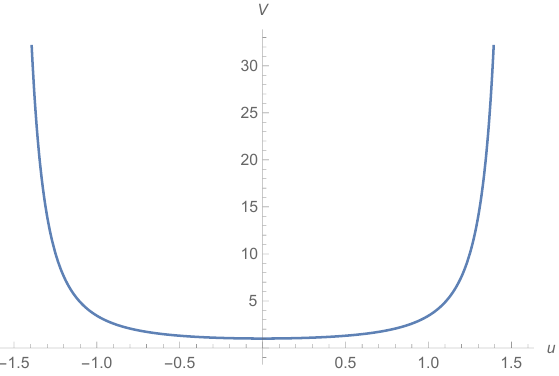
Figure 1 . The potential 1 = cos 2 u . The coordinates are such that we are inside one period and the two AdS boundaries are where the potential blows up. The energies of the associated Schr(cid:127)odinger problem are below